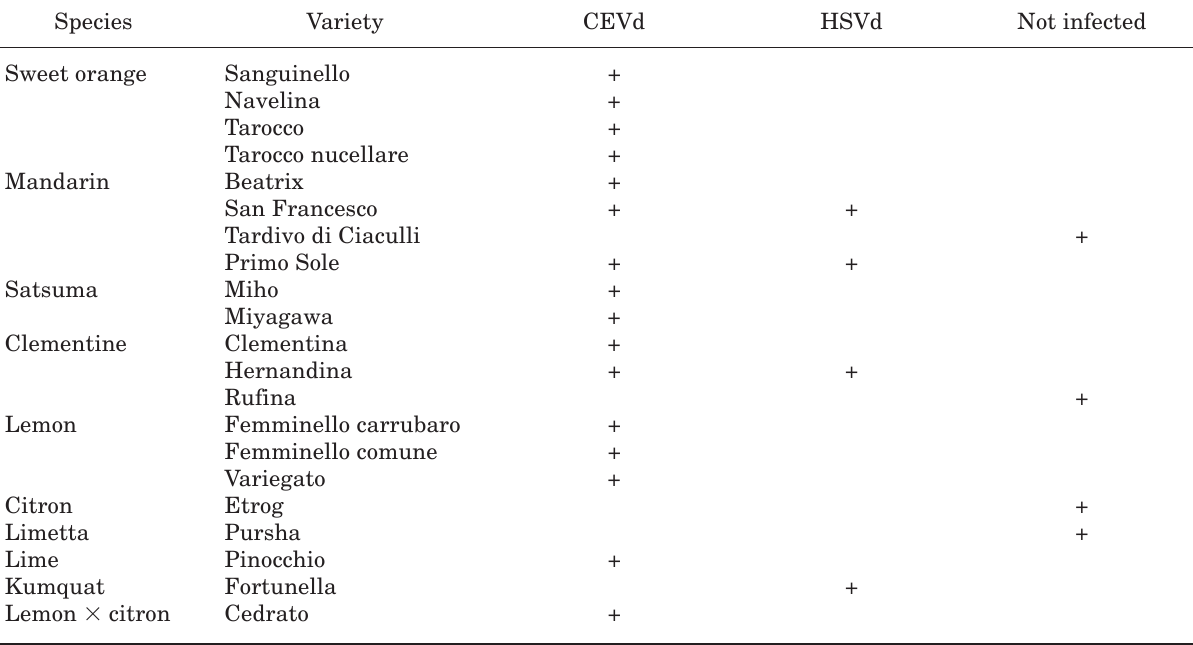
Table 2. Distribution of CEVd in Tuscany and Lazio.